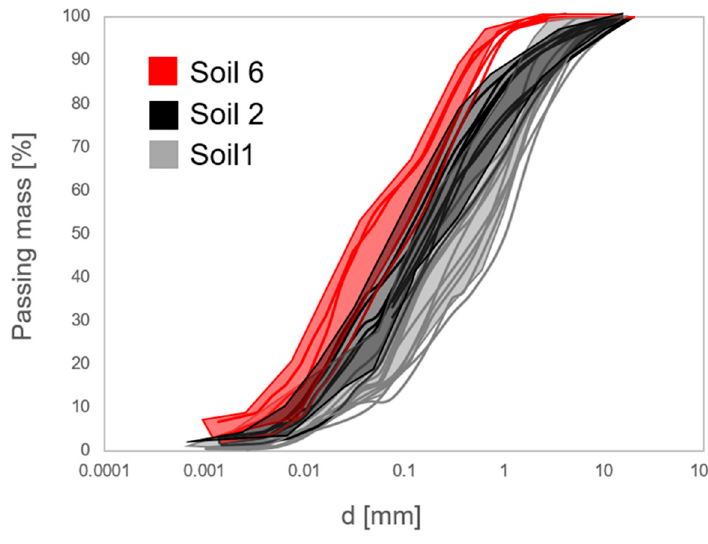
Figure 2. Grain size distributions of the soil tested: soils 1 and 2; soil 6. Table 1. Mean physical properties of tested soils, sample sizes, and adopted methods.